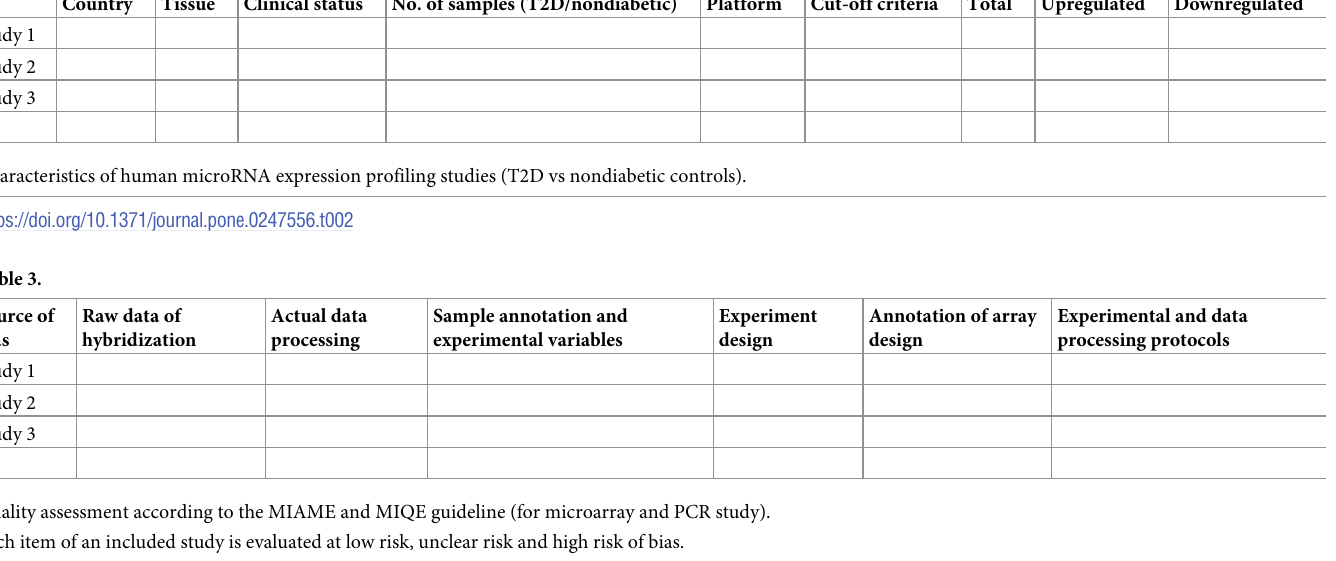
the list of differentially expressed microRNAs (Table 2). The extracted microRNAs will be alignment with miRBase version 22 [30] to unify the names before quality assessment. Quality assessment of microarrays will be performed according to the MIAME guideline version 2.0 [31]. Studies adopted qPCR-based microRNA arrays will be assessed according to the MIQE guideline [32] which should be corresponding to the MIAME guideline (Table 3 and Fig 2). RNA-Seq studies would be assessed according to MINSEQE guideline (Table 4 and Fig 3), pro- posed by FGED Society in 2012 (http://fged.org/projects/minseqe/). And the quality of tran- scriptomic parts of included studies will be assessed, including the collection of raw data, actual data processing, sample annotation, experimental design, array annotation, and data processing protocol. Each item is evaluated with low risk, unclear risk and high risk, suggesting high reproducibility, ambiguous reproducibility and low reproducibility, respectively.